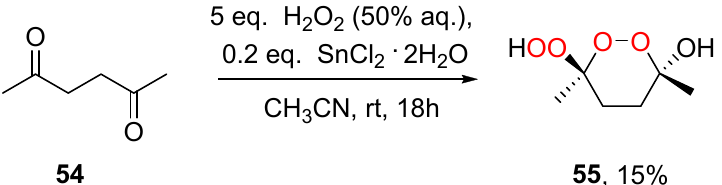
Scheme 20. Synthesis of dihydroperoxy-1,2-dioxolane 53 from acetylacetone 52 . The SnCl 2 ·2H 2 O/H 2 O 2 system was used in the peroxidation of 2,5-heptadione 54 . In